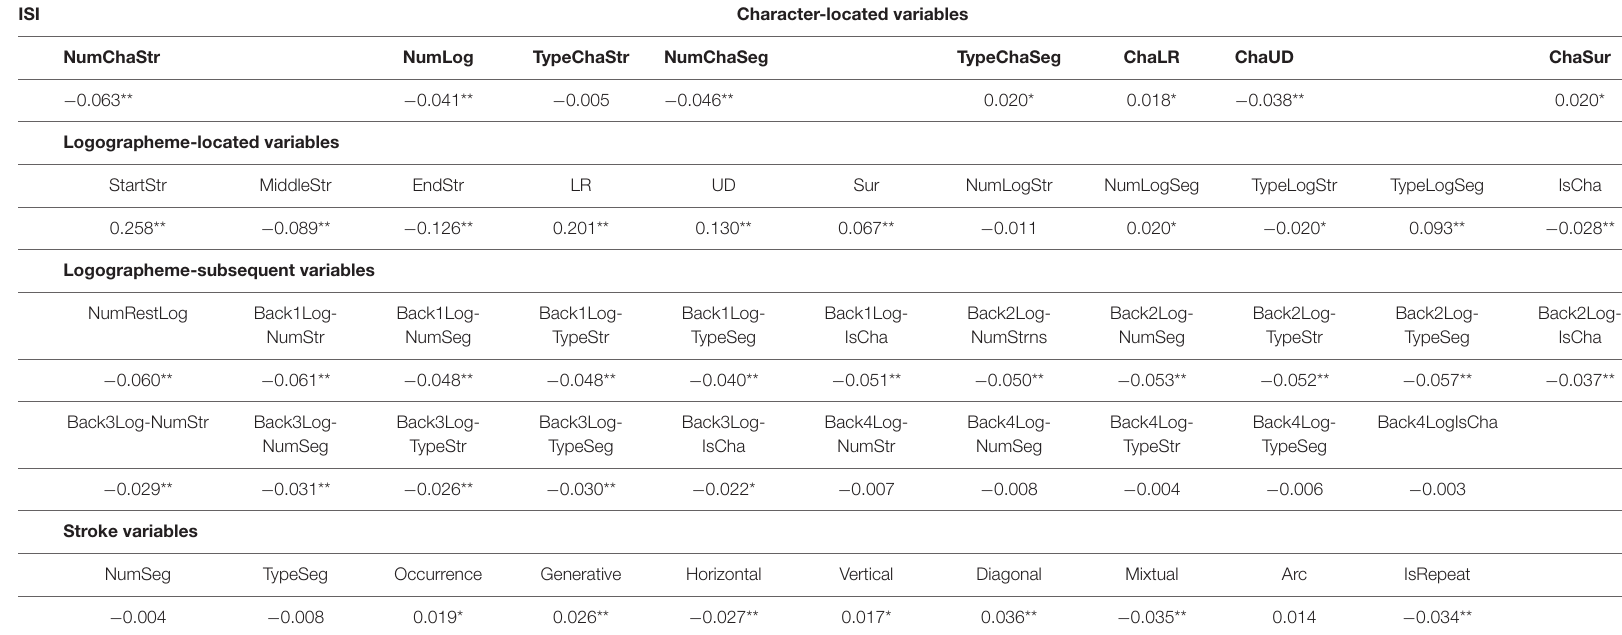
Symbol * indicates significance at the 0.05 level. Symbol ** indicates significance at the 0.01